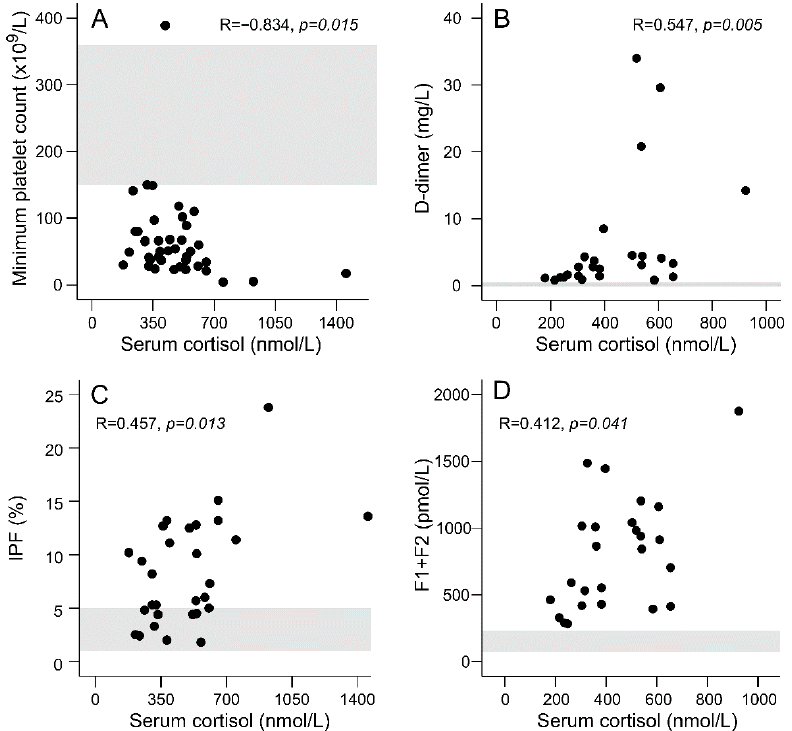
Figure 3. Scatter plots illustrating the correlations between serum cortisol level and the minimum platelet count ( A ), D-dimer ( B ), immature platelet fraction (IPF; C ) and plasma prothrombin fragments (F1+F2; D ) in patients with acute Puumala hantavirus infection. The reference ranges are marked with shading. Table 4. Platelet count and markers of thrombopoiesis, thrombin formation and fibrinolysis during acute PUUV infection in patients with normal hormone levels, and in those with overt central or peripheral hormonal defects.